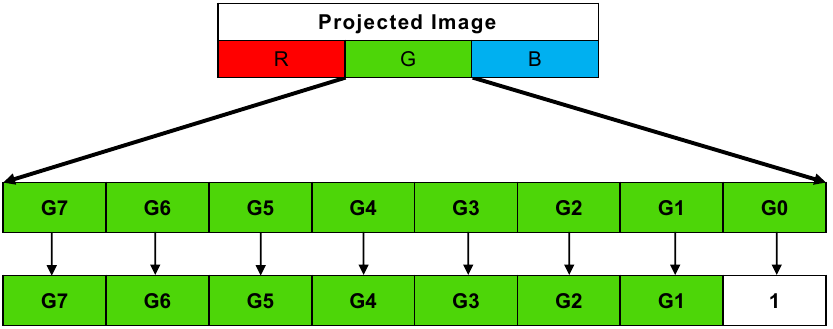
Figure 14. Background subtraction